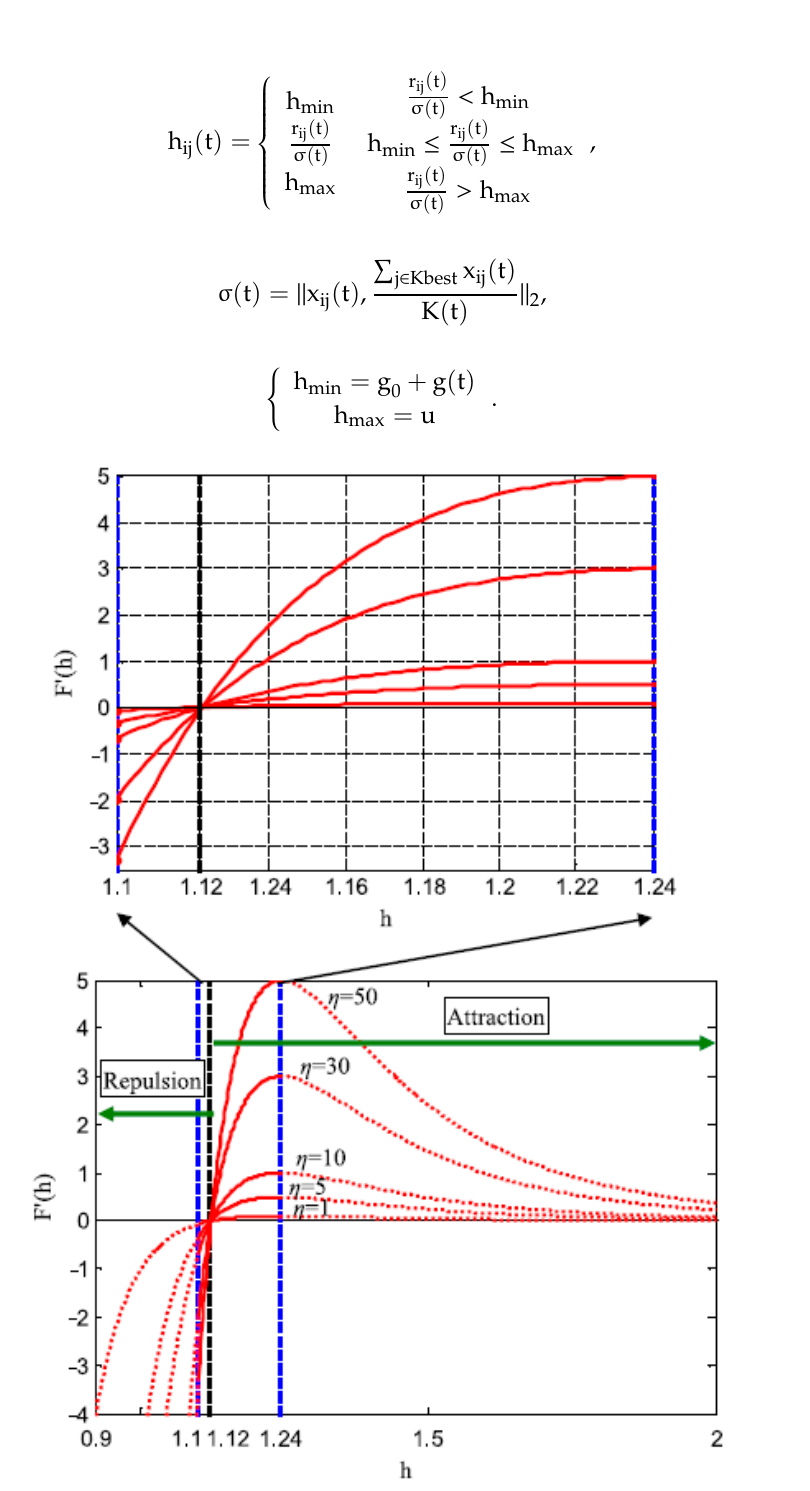
(cid:48) against η